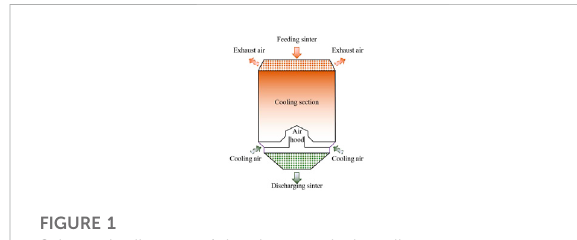
FIGURE 1 Schematic diagram of the sinter vertical cooling